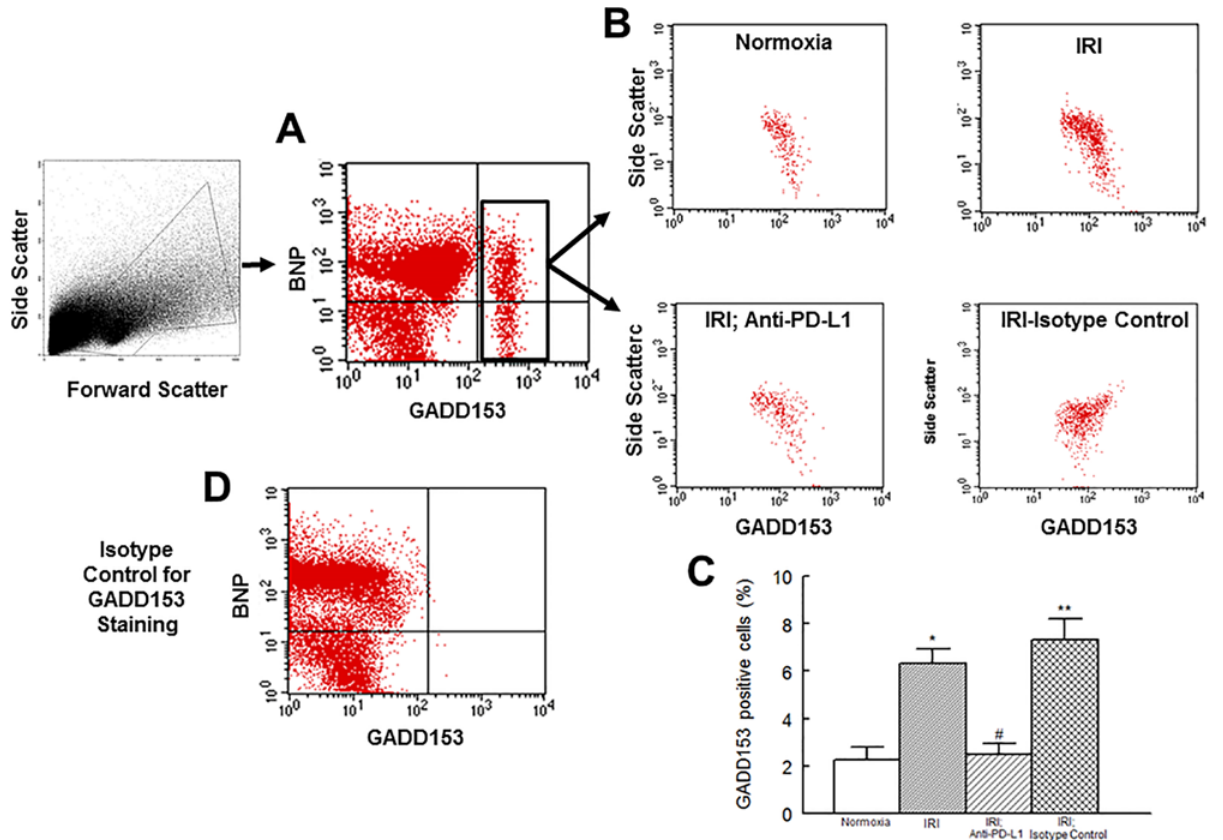
Fig 3. Under panel A, flow cytometry profile of cardiac cell preparation is shown along with a representative dot plot showing the expression of GADD153 in cardiac cell preparation; BNP was used to differentiate cardiomyocytes from other cardiac cells. Under panel B, representative dot plots are shown for GADD153+ cardiac cells from experimental groups. On the other hand, bar graphs, under panel C, show percent of cardiac cells which were positive for GADD153; data are means ± SEM; n = 6 hearts/group for normoxic control, IRI and IRI; Anti-PD-L1 and n = 4 for IRI; isotype matching control. Also shown, under panel D, is the staining isotype control for GADD153 from FACS analysis for gating purpose. IRI: Ischemia Reperfusion Injury. * p < 0.05 compared to the normoxic group. ** p < 0.05 compared to normoxia or IRI; Anti-PD-L1 group. # p < 0.05 compared to IRI or IRI; isotype control group.